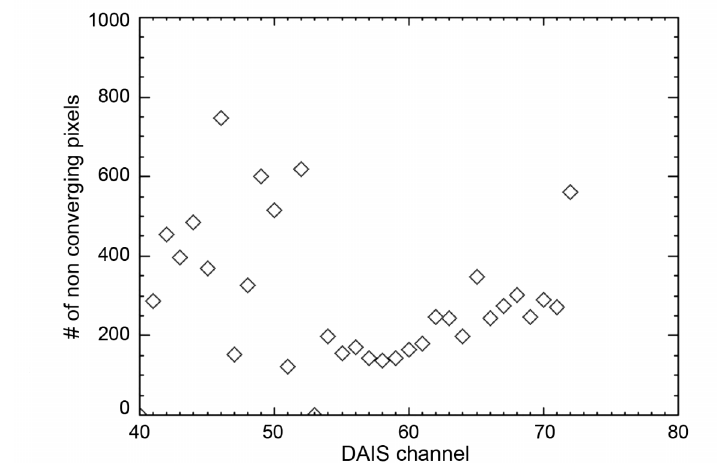
Fig 6. Histogram of the number of pixels in the case of no solutions from DB